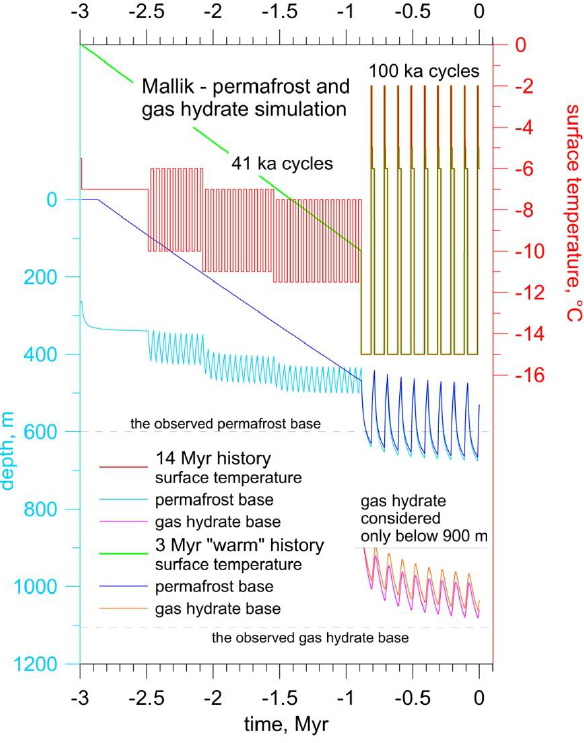
Fig. 10. An illustration of the sensitivity of current Case 1 model results to potential uncertainties in the earlier GST history, prior to the 100 ka cycles. The model comparison of a ―warmer‖ GST model (light green) to a ―colder‖ GST model based on 14 Myr record of global marine isotopic data adjusted to the Mallik site. The ―warmer‖ model is up to 6 K higher for most of the period between 3 Myr and 0.9 Myr ago. Current difference between these two models is tens of meters, at most. It indicates that the youngest part of the model is not very sensitive to the early parts of the GST history.